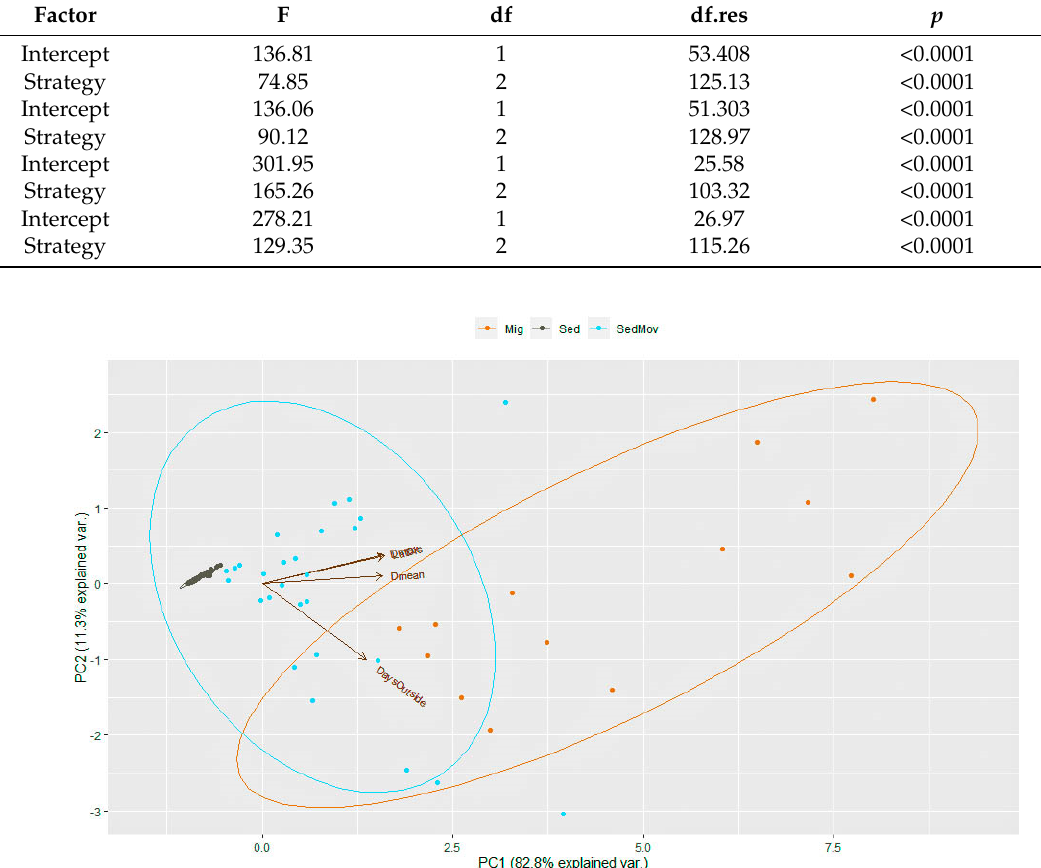
Table 2. Results of the ANOVA tests based on the previous LMMs (see Table S3). Estimates, F value, degrees of freedom (df), degrees of freedom of the residuals (df.res), and p value are shown. n = 136. p < 0.0001 for all strategy pairwise comparisons.